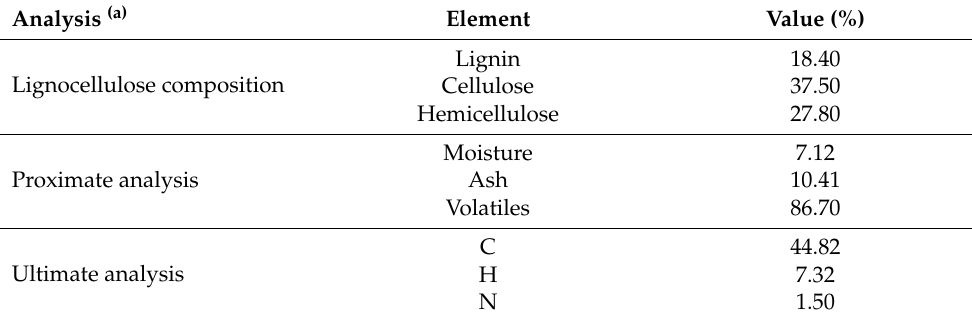
Table 2. Wheat straw analysis data.